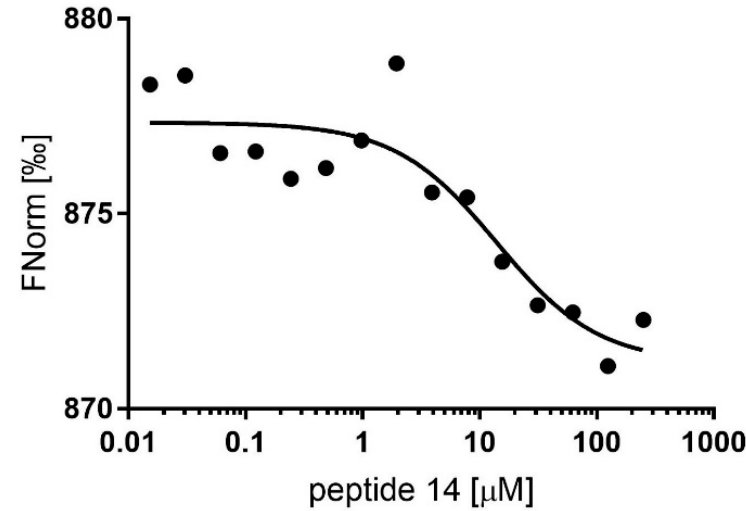
Figure 3. MST analysis of the binding of peptide-14 to Hub1.